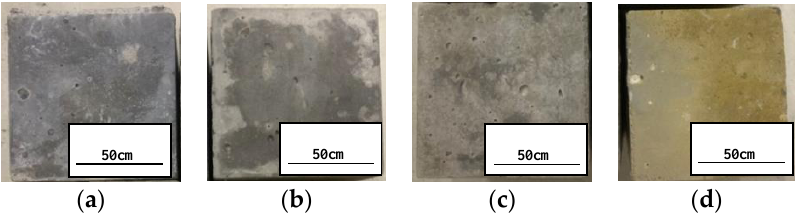
Figure 3. The morphology of concrete specimens at 70 °C and 90 days: ( a ) 0; ( b ) 2000; ( c ) 7000; ( d ) 180,000 ppm.